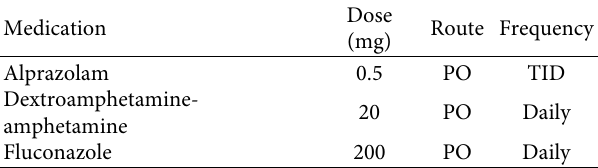
Table 1: Outpatient medications at the time of liver